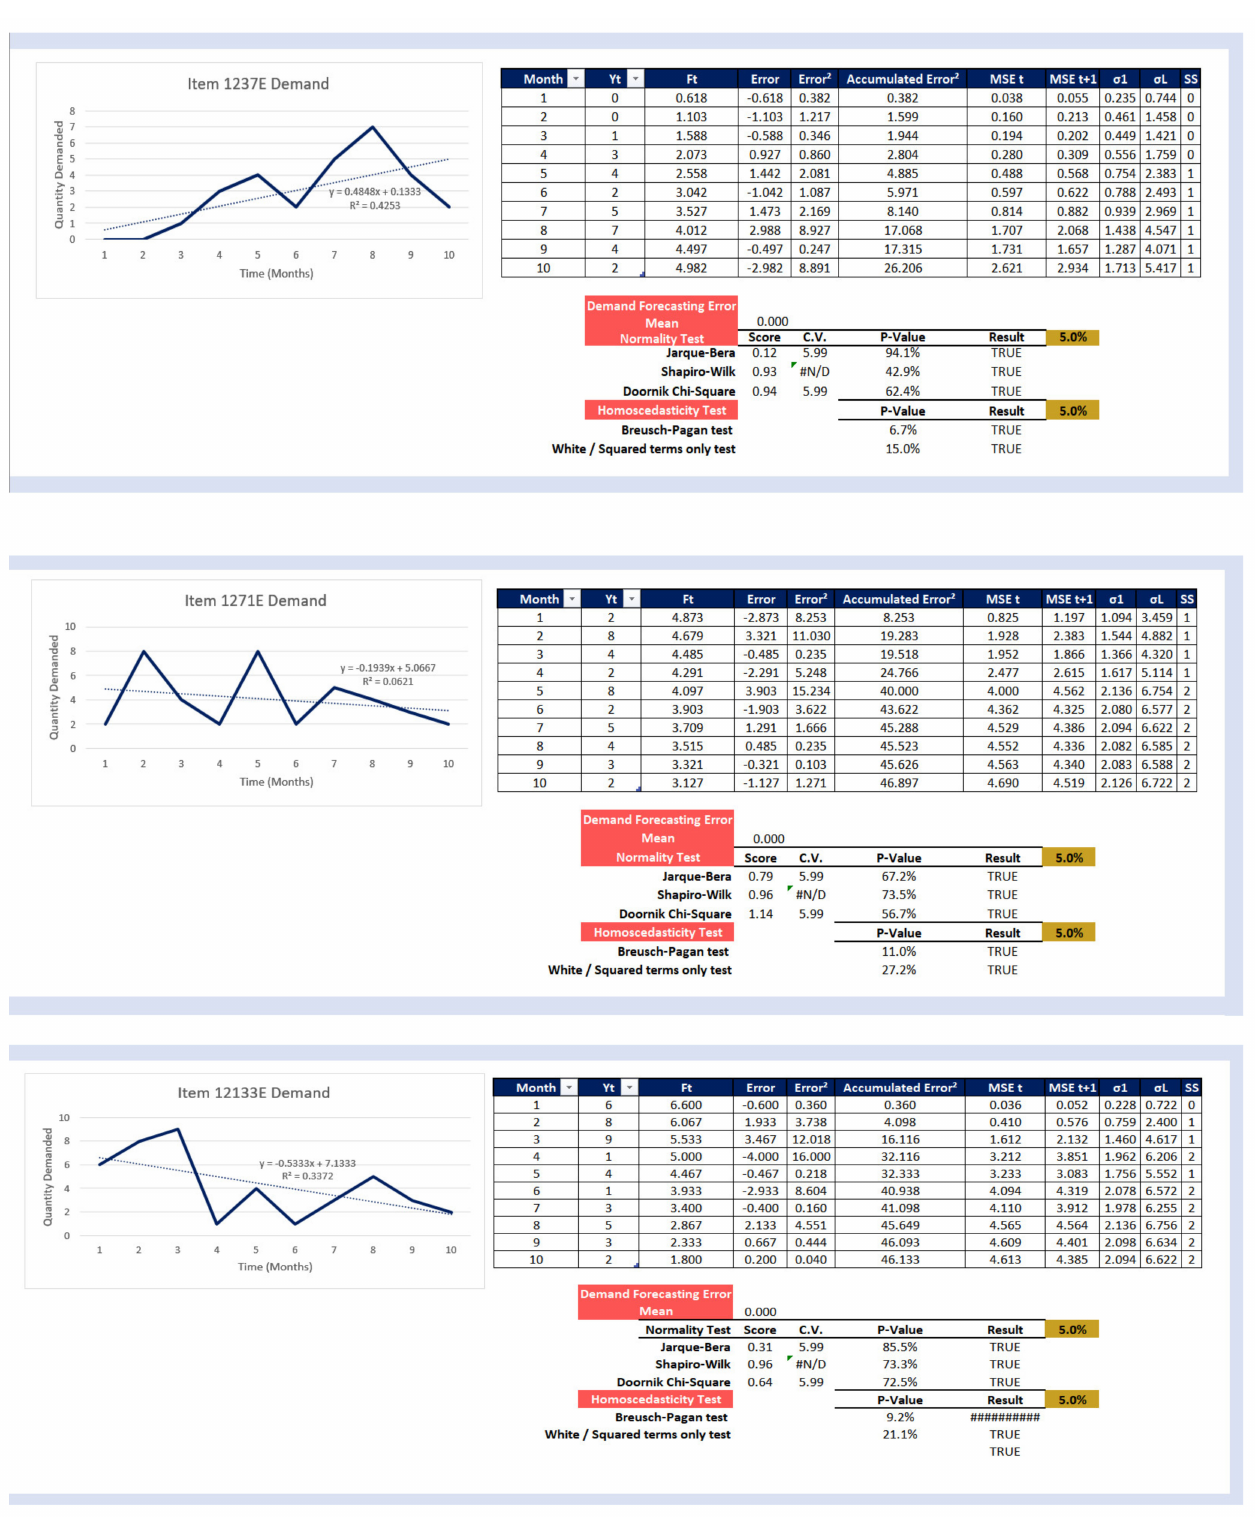
Figure 8. “Auxiliary Calculation”